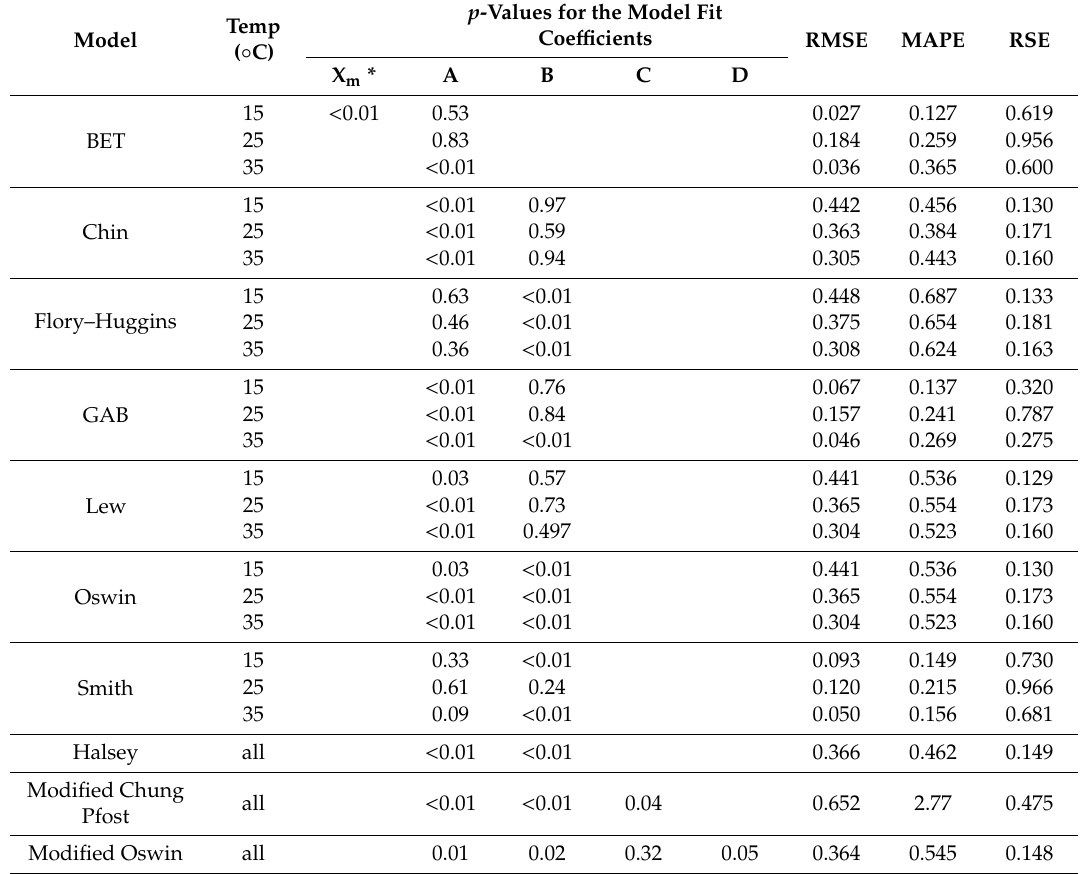
Table 4. Model fit coe ffi cients and error